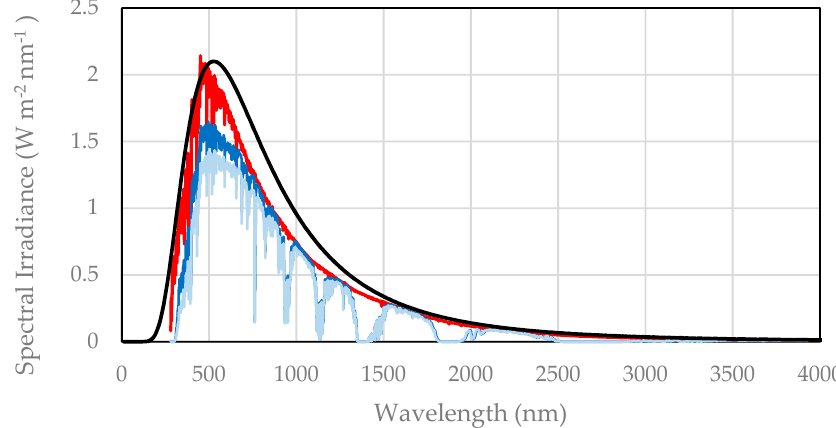
Figure 1. Plot of the direct normal spectral irradiance, AM1.5 ( ___ ); global total spectral irradiance on a 37° tilted sun-facing surface, AM1.5 ( ___ ); the extraterrestrial spectrum, AM0 ( ___ ); and the blackbody irradiation spectrum at 5500 K ( ___ ) [10,11].